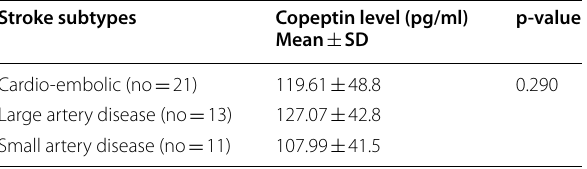
Table 4 Copeptin level in different stroke subtypes according